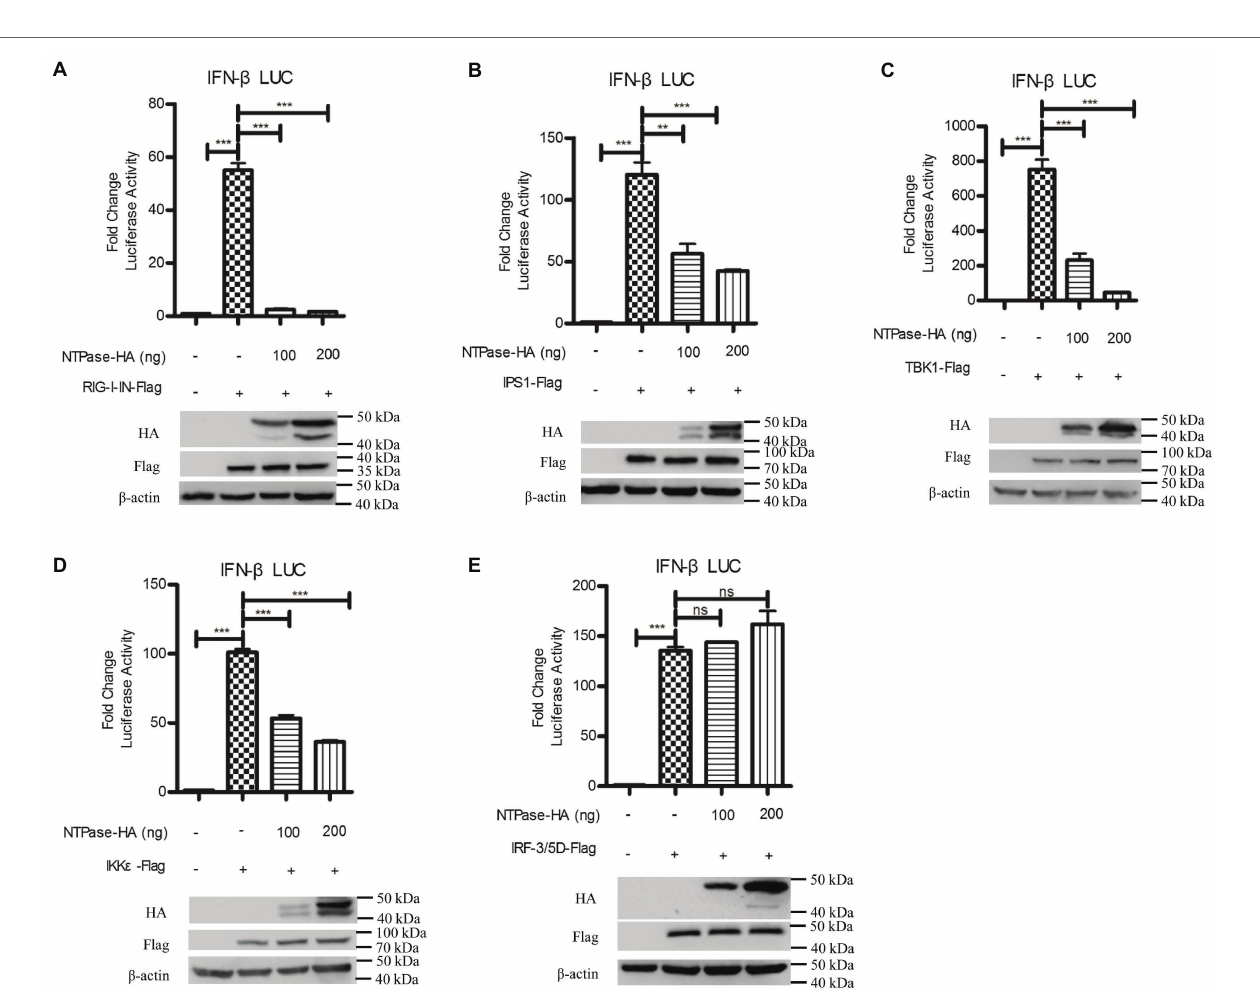
FIGURE 4 | HuNoV NTPase blocks IRF-3 signaling at the stage of tANK-binding kinase 1 (TBK1)/IKK ε kinase. (A-E) Various amounts of HA-tagged NTPase expression plasmid or empty vector together with 100 ng p125-Luc and 20 ng phRL-TK, together with 20 ng retinoic acid-inducible gene (RIG)-I-IN (A) , IPS1 (B) , TBK1 (C) , IKK ε (D) , or IRF-3/5D (E) expression plasmid were cotransfected into HEK 293T cells preseeded in 48-well plates for 40 h. Cells were harvested and luciferase activities were measured with DLR assay. Protein expression was monitored by WB using anti-HA or anti-Flag Ab. β -actin was used as a loading